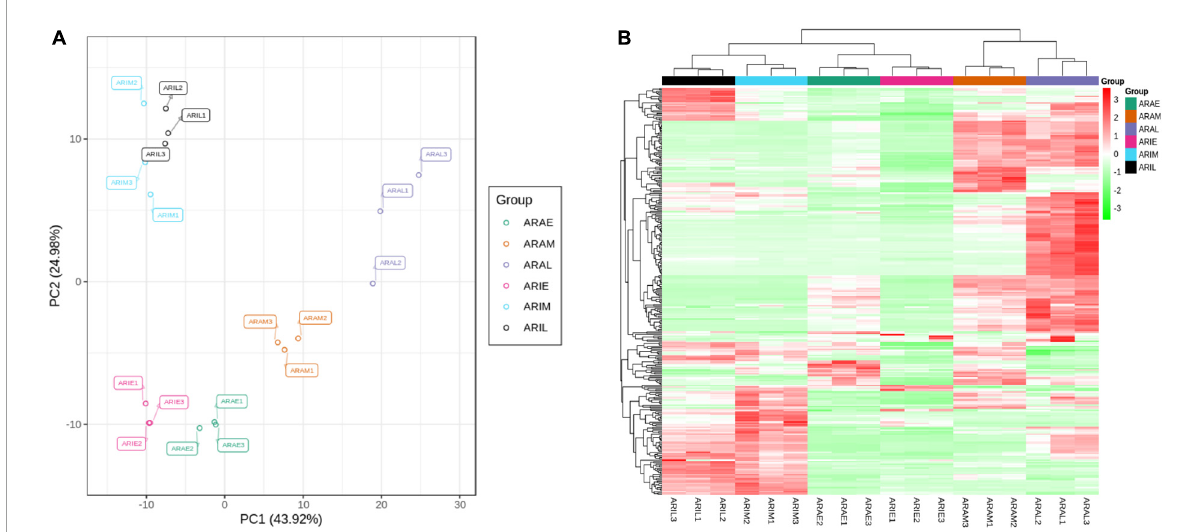
FIGURE4 Differential flavonoid metabolites analysis. (A) PCA of flavonoid metabolites of A. argyi and A. indica . Each point in the figure represents a sample, and samples of the same group are represented by the same color. (B) Clustering heat map of flavonoid metabolites of A. argyi and A. indica . The X-axis represents the name of the sample, and the Y-axis represents the metabolite information. Different colors are the values obtained after the standardization of the relative content, in which red represents the high content and green represents the low content.